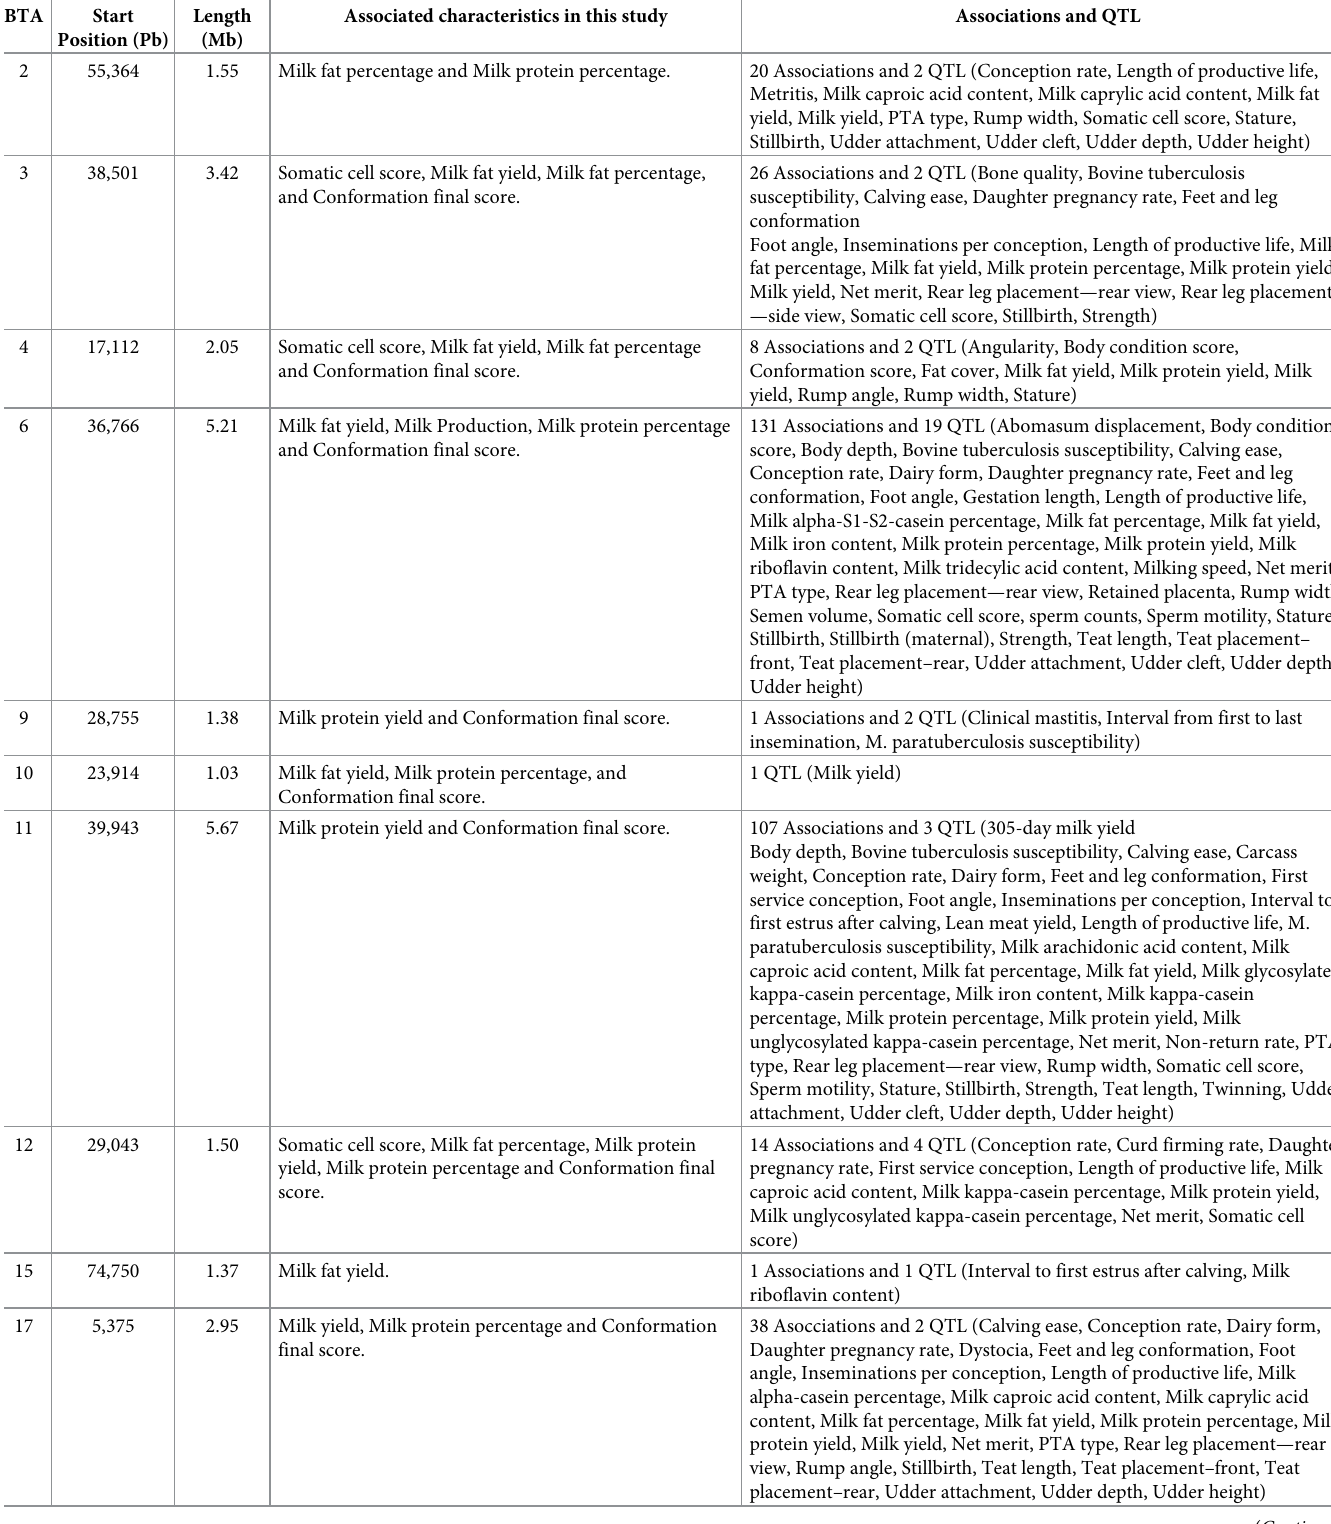
Table 4. Quantitative trait loci and SNP markers identified in the ROH position associated to productive traits and conformation final score in this study. BTA Start Length Associated characteristics in this study Associations and Position (Pb) (Mb)